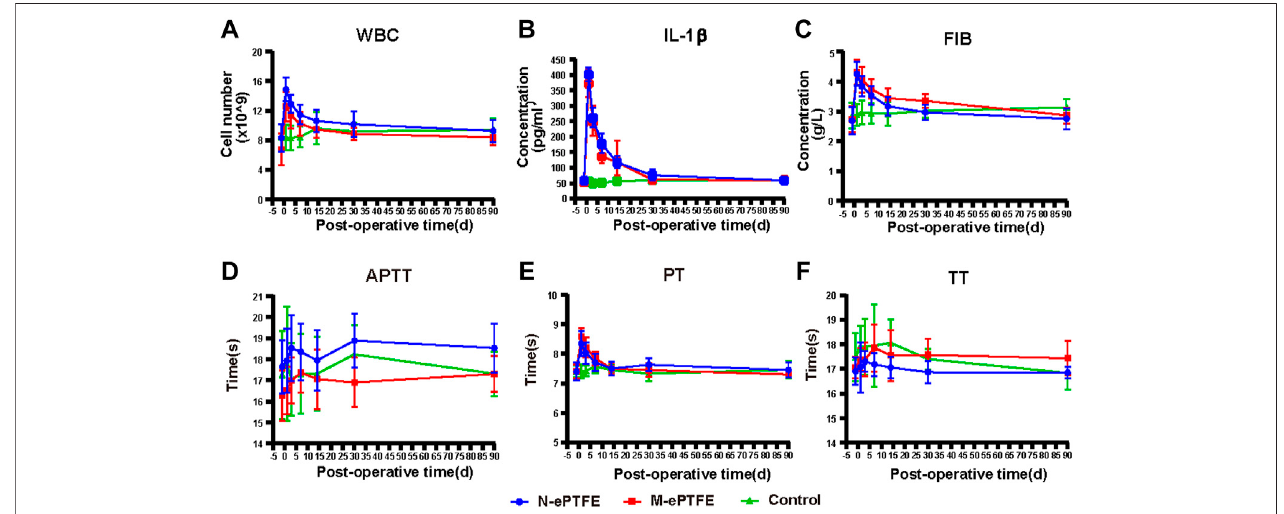
FIGURE 7 | Changes in indexes for in fl ammation (A – C) and coagulation (C – F) in the three groups at each time point(perioperative, 1 d,3 d,7 d,14 d,30 d, 90 d after operation). WBC, white blood cells; IL-1 β , interleukin-1 β ; FIB, fi brinogen; PT, prothrombin time; TT, thrombin time; APTT, activated partial thromboplastin time;